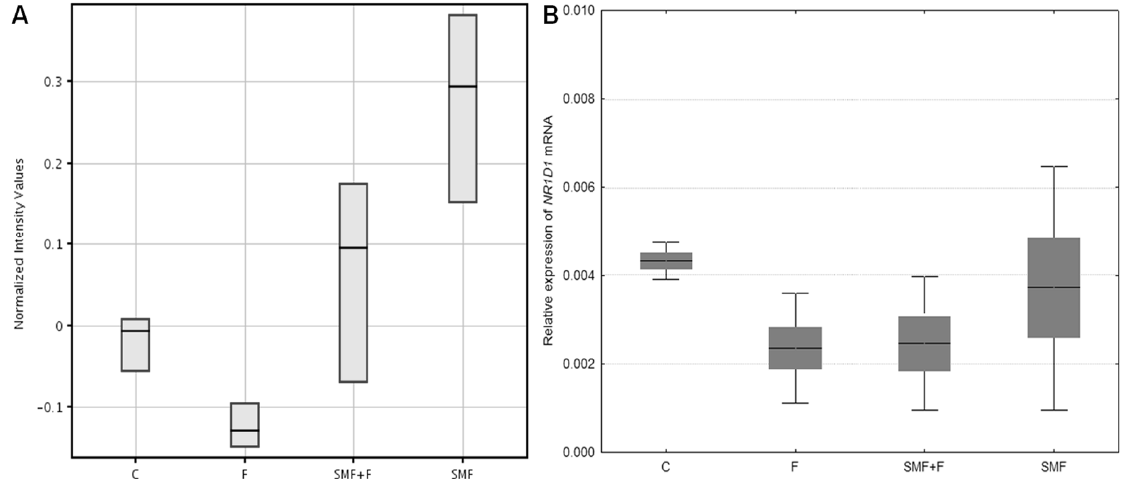
Figure 2. Expression of the NR1D1 gene in the control cells (C), F − -treated cells (F), cells that had been exposed to a static magnetic field (SMF), and cells that had simultaneously been exposed to a static magnetic field and F − (SMF + F) that was determined using the oligonucleotide microarray technique ( A ) and the RT-qPCR technique ( B ). The results are presented as the mean ± SE (box) and SD (whisker).